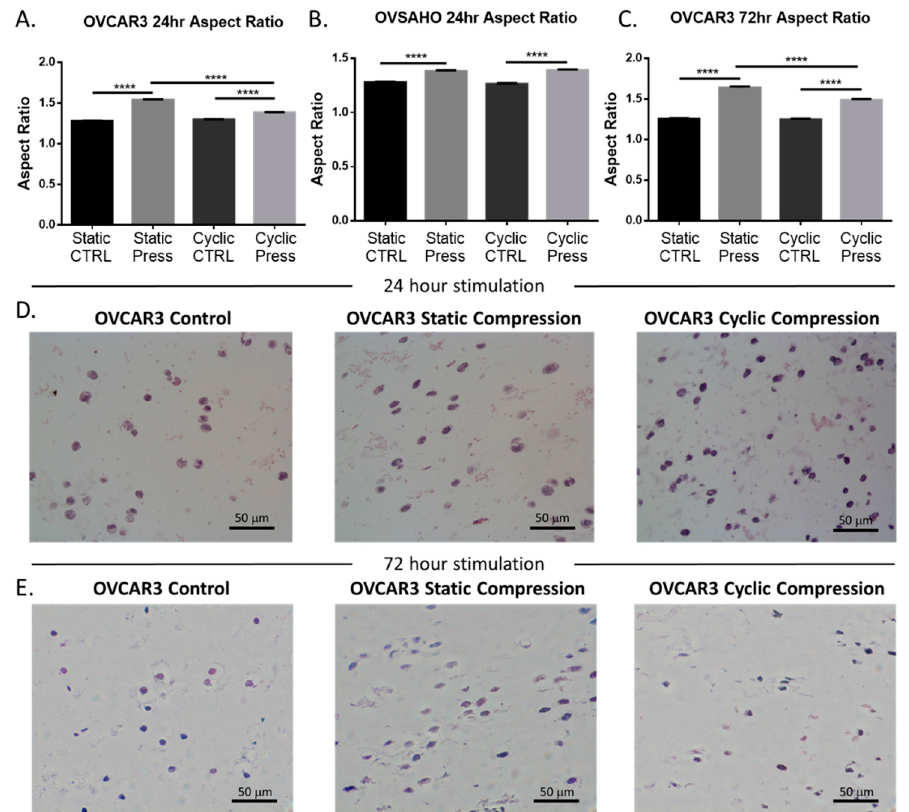
Figure 2. Cyclic and static compressive stresses cause significant morphological changes in high grade serous ovarian cancer cells indicating increased invasive potential. ( A ) 24 h compressive stimulation of OVCAR3 cells under static or cyclic loading; ( B ) 24 h compressive stimulation of OVSAHO cells under static or cyclic loading; ( C ) 72 h compressive stimulation of OVCAR3 cells under static or cyclic loading; ( D ) Representative images of ovarian cancer cellular morphology under control, static, or cyclic loading conditions at 24; ( E ) and 72 h. (Significance calculated via one-way ANOVA; n ≥ 3 experimental replicates, **** p < 0.0001, *** p < 0.001, ** p < 0.01, * p < 0.1).